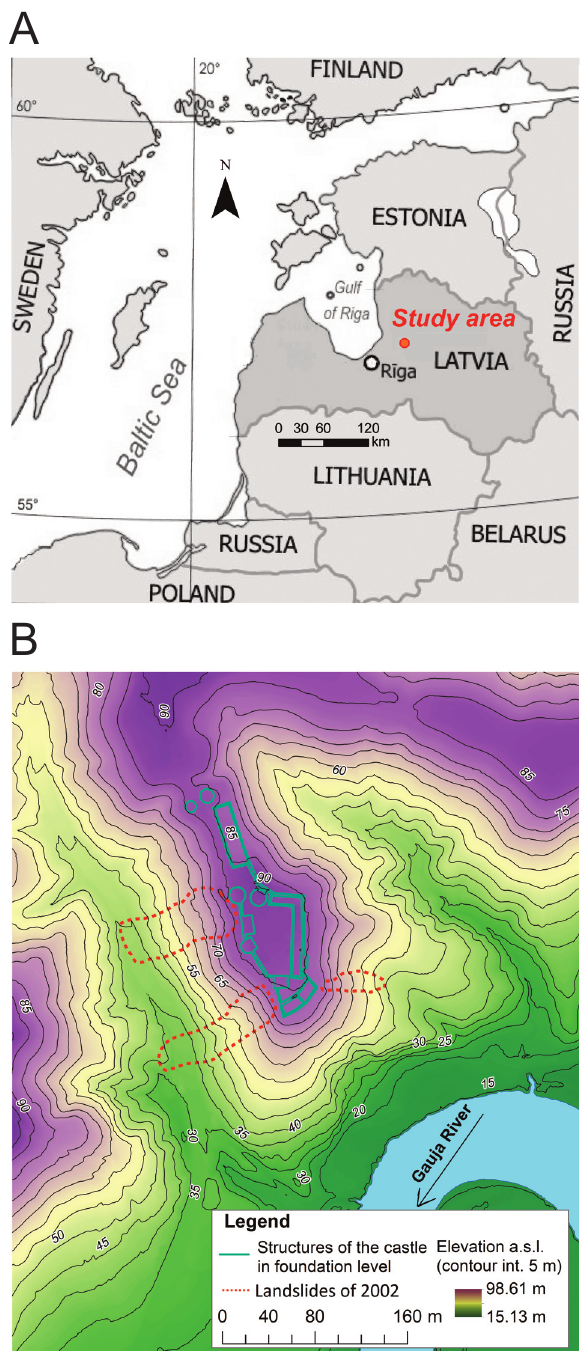
Fig. 1. Location of the study area in a regional ( A ) and local ( B ) scale (compiled after M ū rnieks et al. 2002; LGIA